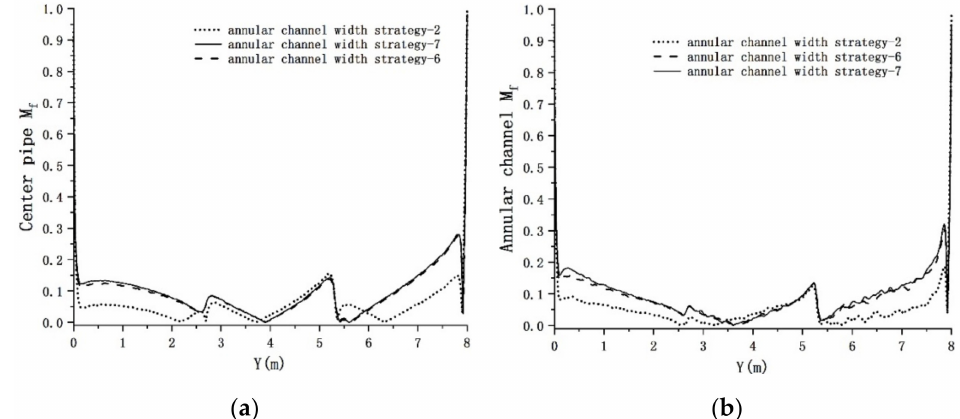
Figure 17. Non-uniformities for different annular channel width strategies: ( a ) non-uniformity at the location of the Center pipe, ( b ) non-uniformity at the location of the Annular pipe.